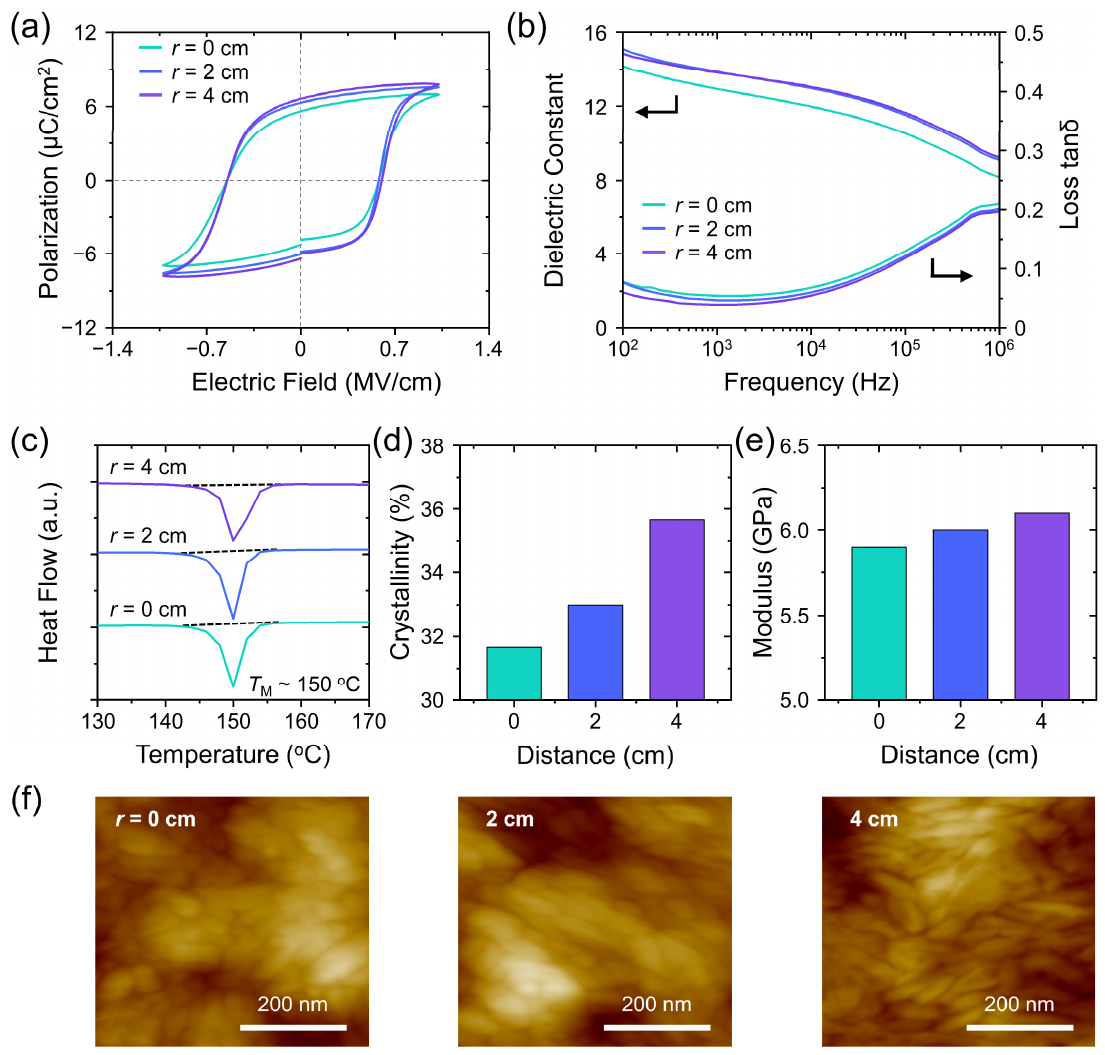
Figure 2. Distance-dependent ( a ) ferroelectric hysteresis loop, ( b ) dielectric constant and loss tanδ, ( c ) differential scanning calorimetry (DSC) heating thermogram, ( d ) crystallinity, ( e ) Young’s mod- ulus, and ( f ) surface morphology of P(VDF-TrFE) films. In ( a – f ), the rotational speed was fixed at ω = 3000 rpm. In ( c ), the dashed lines represent the linear baselines for the enthalpy calculation. The T M represents the melting temperature of